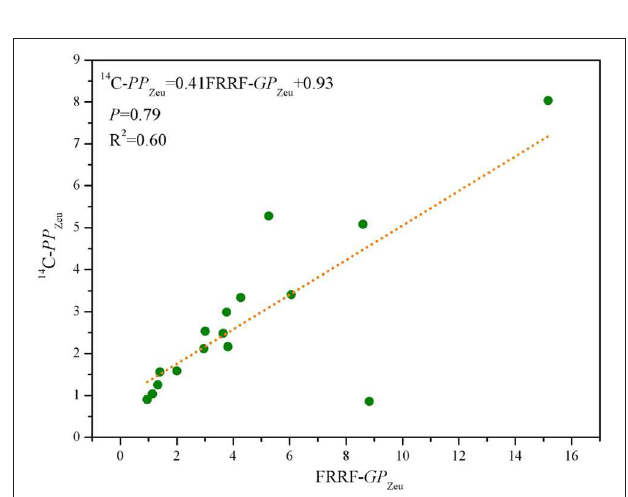
FIGURE 7 | Scatter plots of FRRF- GP Zeu and 14 C- PP Zeu [mg C (mg chla) − 1 h − 1 m − 2 ] for pooled data of 16 stations in the BOB.